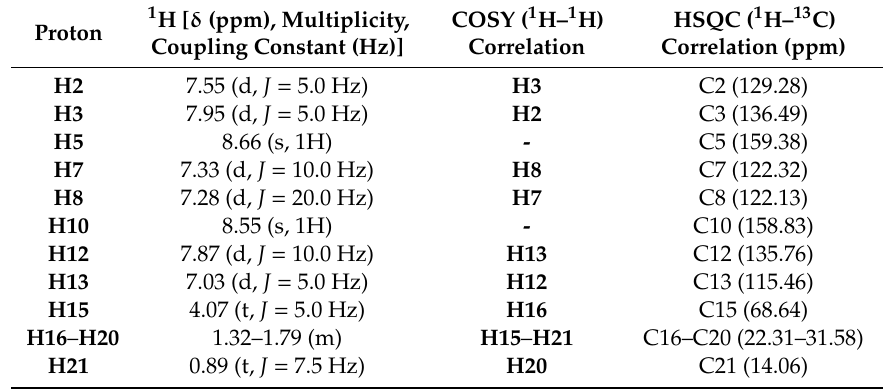
Figure 6. HSQC ( 1 H– 13 C) spectrum of compound 4a . Table 1. 1 H, COSY, and HSQC NMR data of compound 4a .